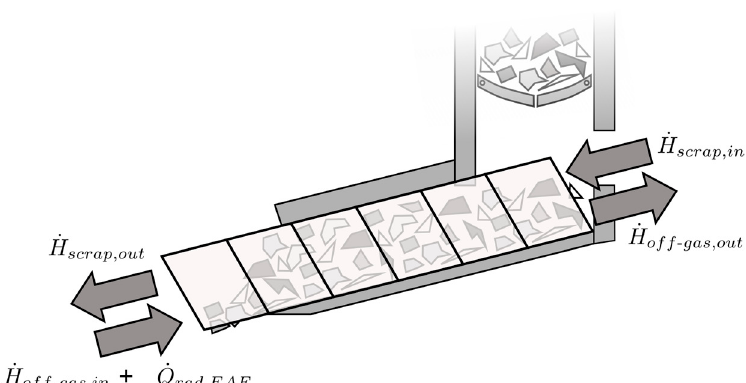
Figure 4. Illustration of first discretization step.